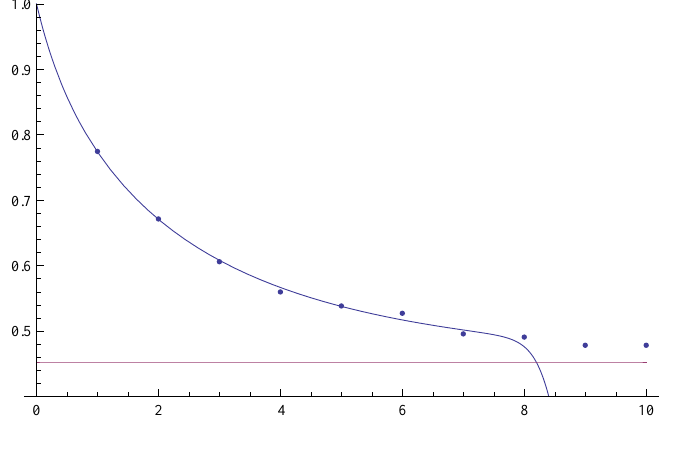
Figure 2. The probability of reaching level x before ruin for J (0) = 1 , X (0) = 0